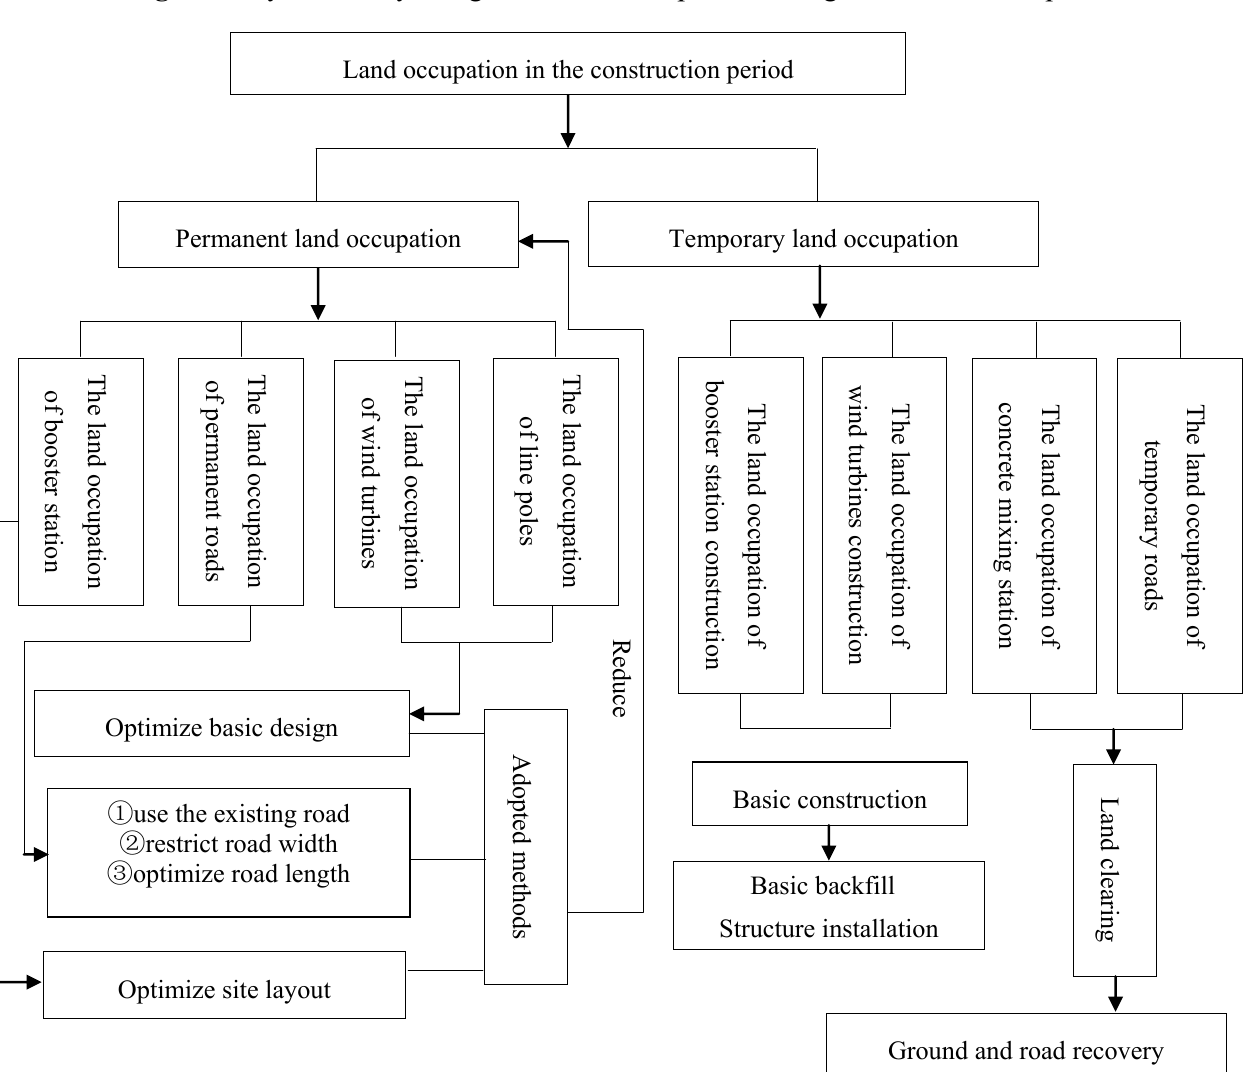
Figure 2. System analysis figure of land occupation during the construction